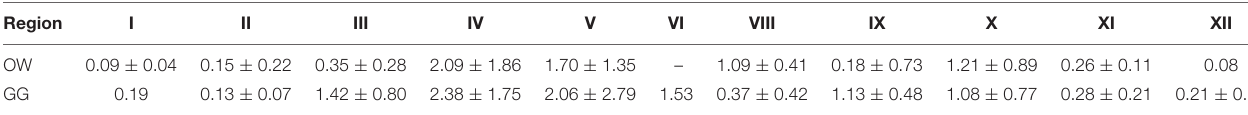
TABLE 3 | Monthly mean of daily primary production integrated in layer 0–30 m, < Pi(0–30) > 26 and standard deviation ( ± SD) expressed in g C m − 2 day − 1 calculated based on data collected within 1993–2018 in the Baltic Proper (OW) and the Gulf of Gdansk (GG). Region